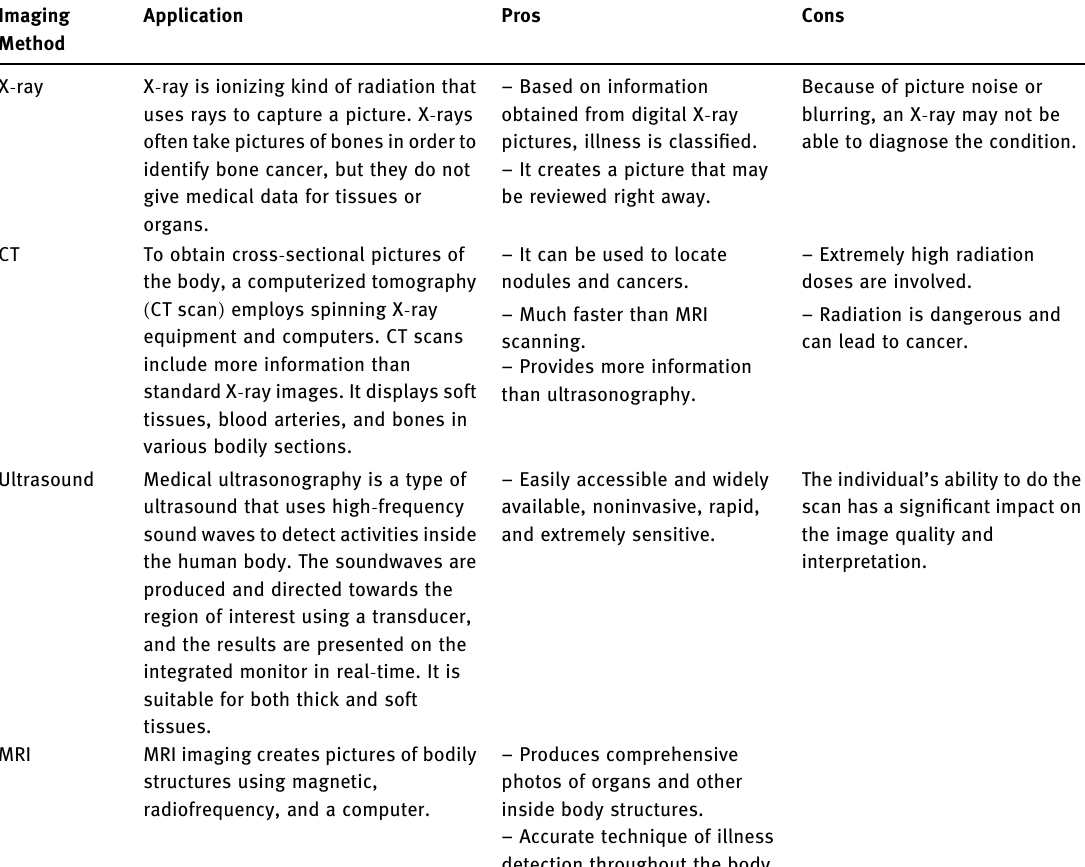
Table 2: Lung imaging methods [ 62